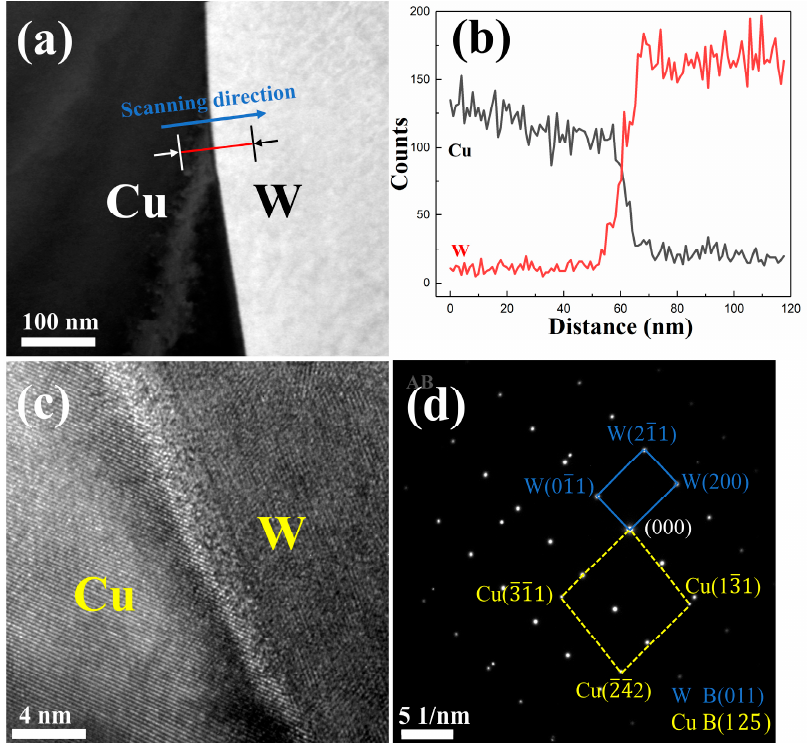
Figure 9. Microscopic characterization for the cross-section of the W/Cu joints: ( a ) drift corrected spectrum profile, ( b ) EDX line-scanning profile along the red-line in ( a ), ( c ) HRTEM image at the interface, and ( d ) selected area diffraction pattern.